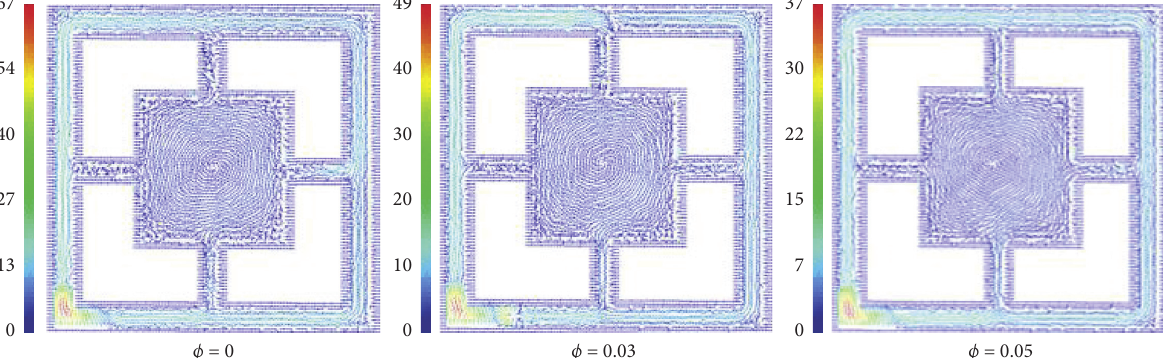
Figure 11: Velocity field below the variations of a solid volume fraction parameter at N � 1 , Ra � 10 4 , Da � 10 − 3 , η ε � 0 . 6 , Le � 20, and τ � 1.